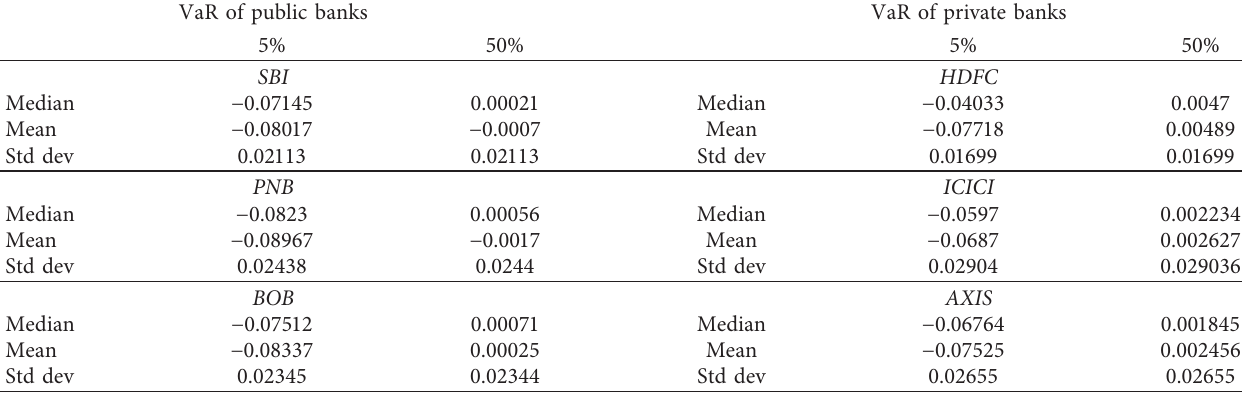
Table 5: Summary of time-varying VaR estimates.